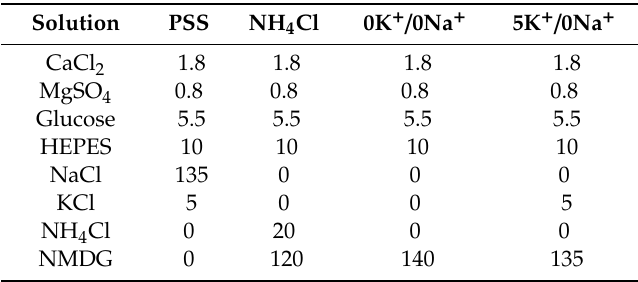
Table 1. Composition of solutions used in the NH 4 Cl pre-pulse. Solution names are listed along the first row, and the composition of each is shown in each column. Components of each solution are in